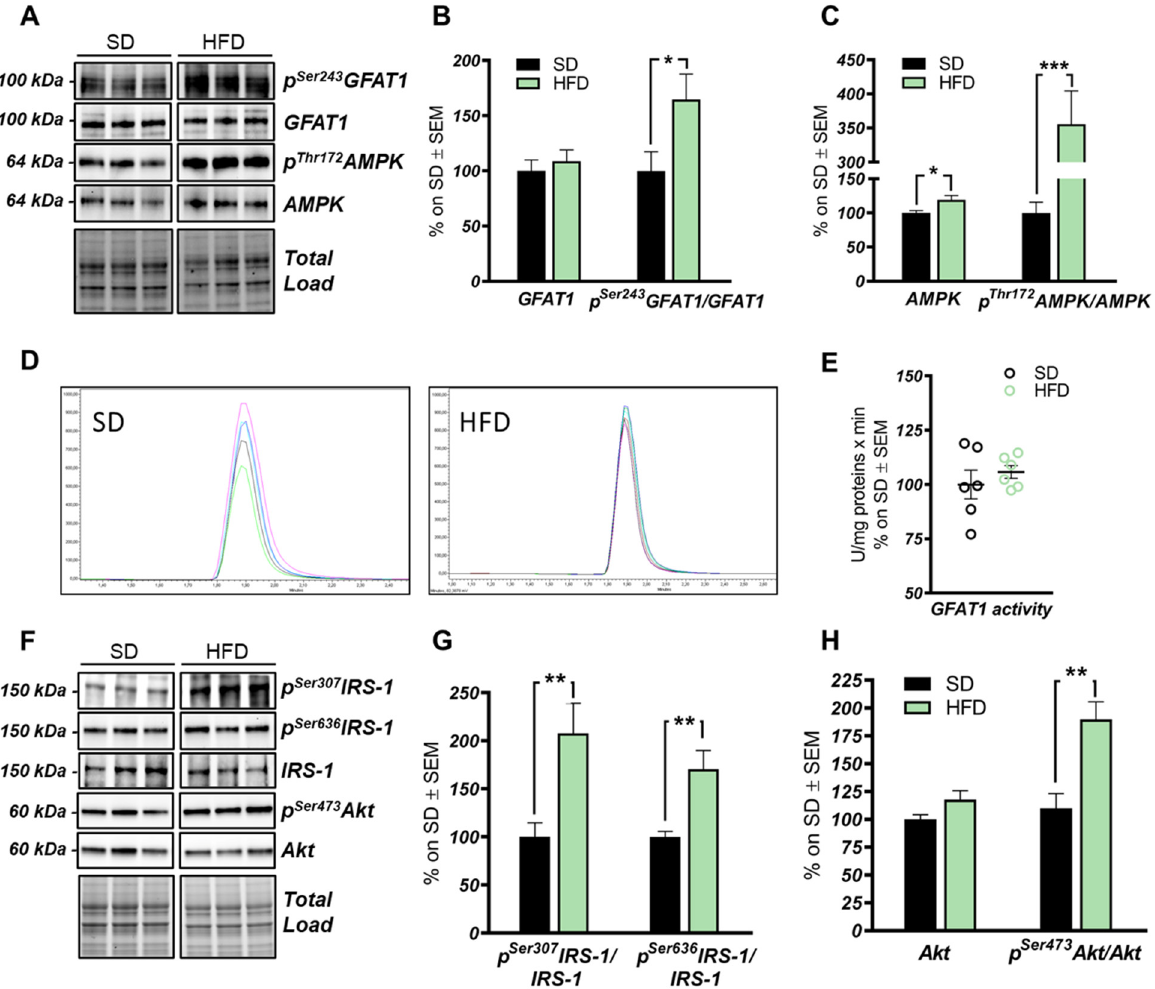
Figure 3. The hexosamine biosynthetic pathway (HBP) flux is impaired in the hippocampus of HFD mice. ( A , B ): Analysis of GFAT1 activation status in HFD mice compared to respective controls. A significantly increased p Ser243 GFAT1/GFAT1 ratio was observed in HFD mice compared to SD, thus resulting in the inhibition of GFAT1 activity. Representative blots are reported in ( A ). ( A , C ) Analysis of AMPK activation status in HFD mice compared to respective SD animals. A significant increase in the AMPK protein levels was observed in HFD, together with a relevant increase in p Thr172 AMPK/AMPK levels, thus resulting in increased AMPK activation. Representative blots are reported in ( A ). ( D , E ) GFAT1 activity assay. No relevant changes were observed in GFAT1’s ability to synthetize glucosamine-6-phosphate in vitro between the HFD group and SD mice. Representative spectra of GFAT1-synthetized glucosamine-6-phosphate for both HFD and SD animals are reported in ( E ). ( F , G ) Analysis of the IRS-1 activation state in the hippocampi of HFD mice compared to SD-fed animals. A relevant increase in both p Ser307 IRS-1/IRS-1 and p Ser636 IRS-1/IRS-1 levels was observed, suggesting a reduction in IRS-1 activation in HFD mice compared to SD. Representative blots are reported in ( F ). ( F , H ) Analysis of Akt activation status in HFD mice compared to respective controls. p Ser473 Akt/Akt ratio was significantly increased in the HFD hippocampal region compared to the same brain area of SD mice. Number of animals for each condition were as follow: n = 6/group for both Western blot analysis and GFAT1 activity assay. All bar charts reported in ( B , C ) and ( G , H ) show mean ± SEM. * p < 0.05, ** p < 0.01, *** p < 0.001 using Student’s t test.